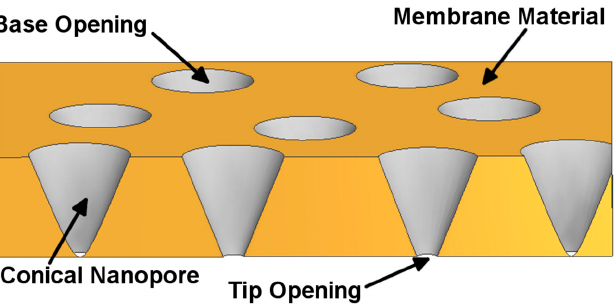
Figure 1. Schematic illustration of a membrane containing conical nanopores. Dimensions are not to scale. to scale. Table 1. Representative asymmetric nanopore systems. Table 1. Representative asymmetric nanopore